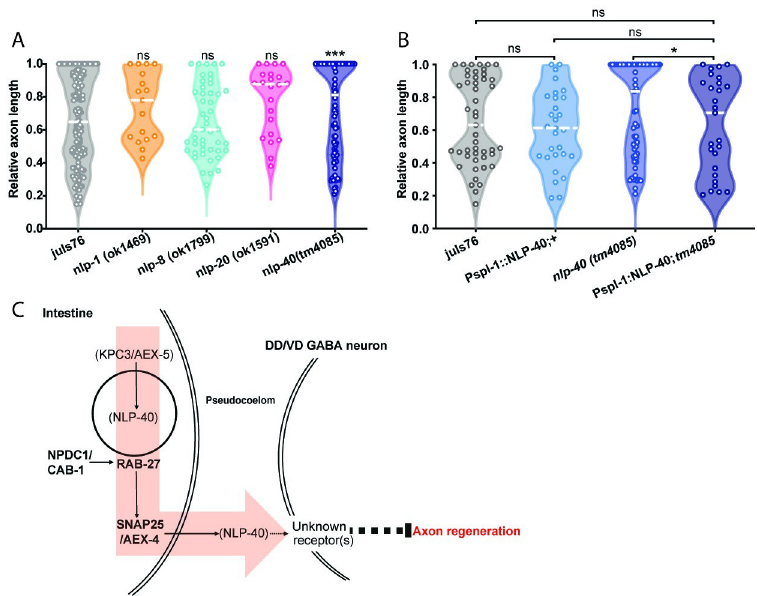
Fig 5. The neuropeptide NLP-40 inhibits axon regeneration. (A) Relative axon length in control animals expressing GABAergic neuron-specific GFP ( juIs76 ), and mutants of several intestinally-expressed neuropeptides: nlp-1 ( ok1469 ), nlp-8 ( ok1799 ), nlp-20 ( ok1591 ) and nlp-40 ( tm4085 ). Axons cut per genotype, L to R: 117, 17, 47, 22, 67. Kolmogorov- Smirnov test was used. ns, not significant, ���� p < 0.0001. (B) Relative axon length in control ( juIs76 ) animals, nlp-40 (tm4085) mutants, and animals expressing sequence for mature NLP-40 peptide under an intestine-specific promoter and stabilized with rab-3 3’ UTR sequence, in both control and nlp-40 mutant backgrounds. Number of axons cut per genotype, L to R: 47, 65, 29, 27. Kolmogorov-Smirnov test was used. ns, not significant, �� p < 0.005. C) Schematic of axon regeneration inhibition from the intestine. NPDC1/CAB-1, RAB-27 and the SNAP25 ortholog AEX-4 form a pathway regulating the tethering and fusion of dense core vesicles at the basal membrane of the intestinal cells. Cargo in these vesicles are secreted into the pseudocoelom, where they signal to GABAergic neurons to inhibit regeneration, through a currently unknown receptor or series of receptors. One secreted inhibitory cargo is the neuropeptide NLP- 40, which is processed by the proprotein convertase KPC3/AEX-5, and is secreted into the pseudocoelom through a SNAP25/AEX-4-dependent mechanism. Disruption in any of these genes leads to enhanced regeneration of the DD/ VD GABAergic neurons.